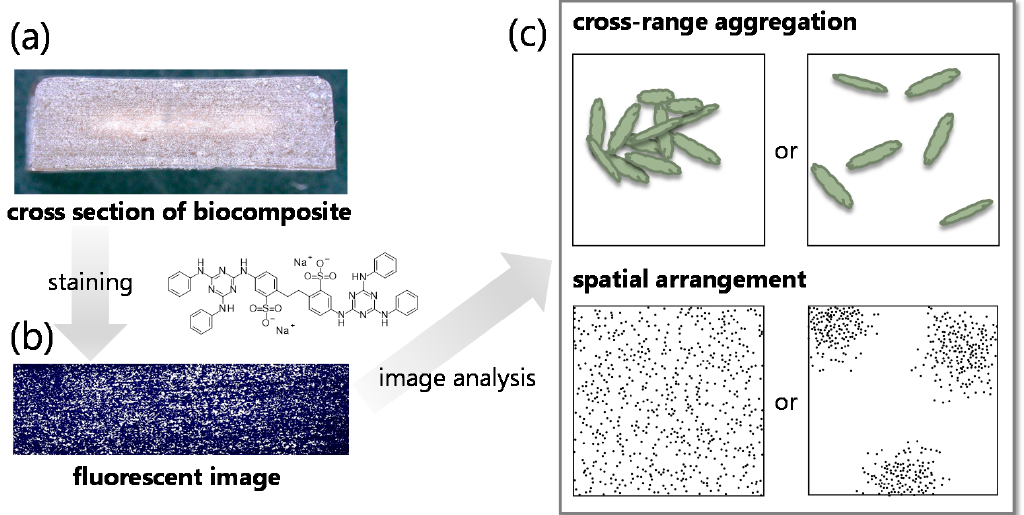
Figure 13. Concept of image analysis by fluorescence staining of a cross section of an injection molding test piece of MCC/MAPP/PP: ( a ) digital camera image, ( b ) fluorescence microscope image (binarized) obtained by staining with CW, and ( c ) viewpoints of filler dispersibility evaluation. Reprinted with some modifications from Ref. [42]. Copyright Elsevier Ltd. (2020).